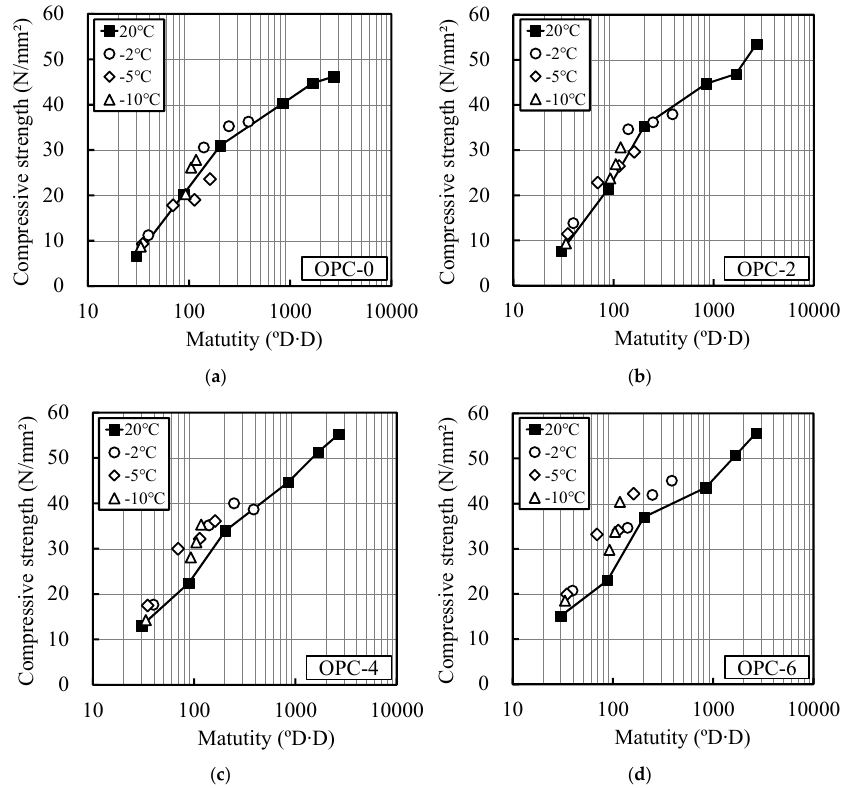
Figure 3. Relation between maturity and compressive strength (OPC): Previous equation for maturity, ( a ) OPC-0; ( b ) OPC-2; ( c ) OPC-4; ( d ) OPC-6.